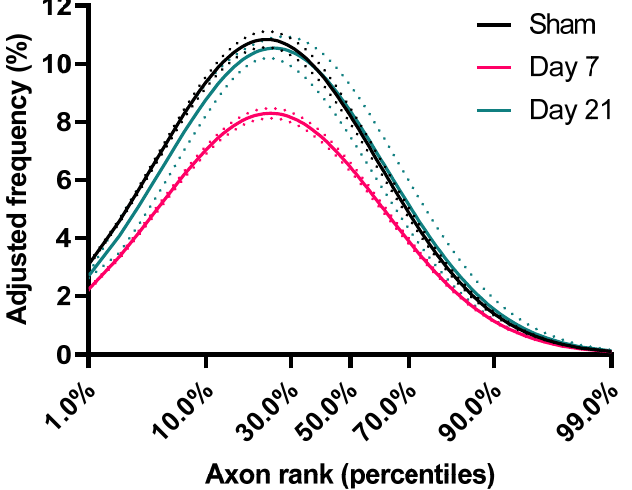
Figure 3. Frequency distribution of axons based on ranking. For each group, axon caliber ranks (percentiles) were calculated and shown against estimates of their corresponding frequencies (adjusted for axon losses). These estimates were imputed from the lognormal curves of the underlying ADD (as per Figure 2B). Dotted lines represent standard error of the mean.